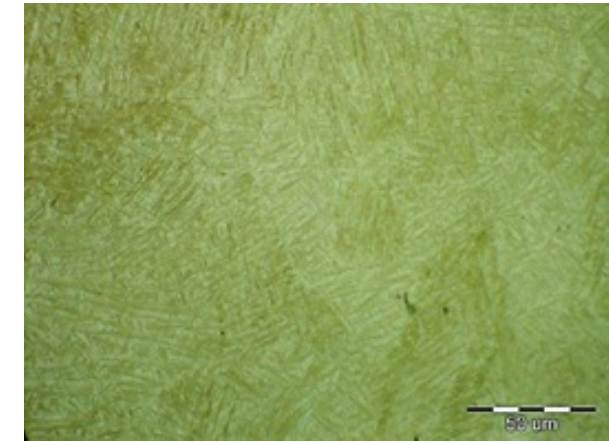
Figure 2: Microstructure of sintered materials, mag. 500 x,